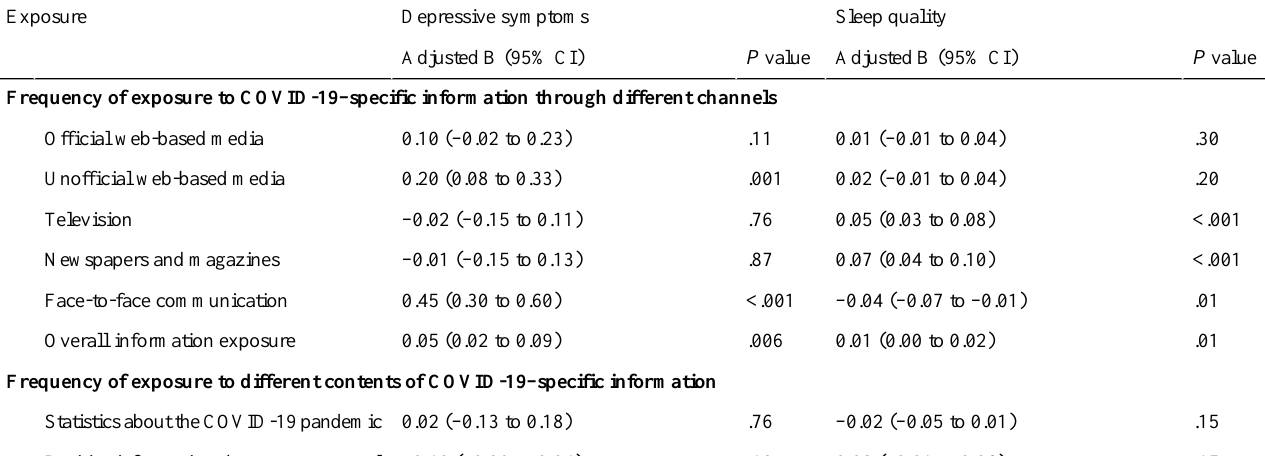
Sleep qualityDepressive